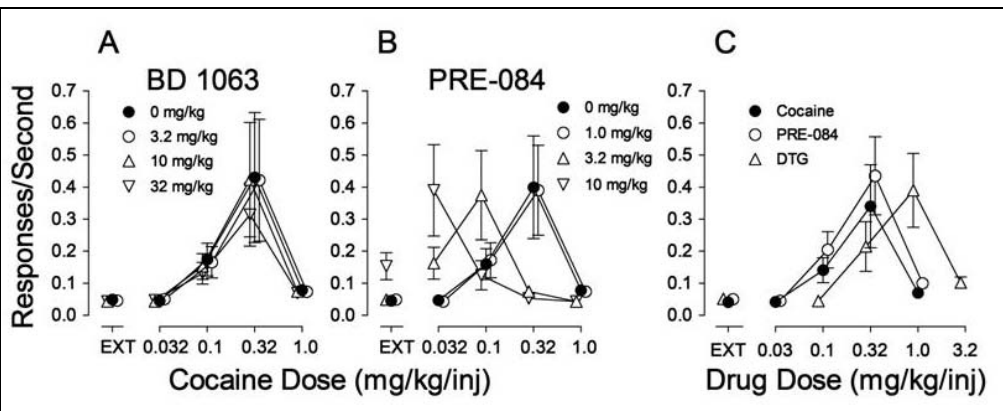
Figure 4. Reinforcing effects of cocaine, its modification by σ R agonists and antagonists, and their substitution in rats trained to self administer